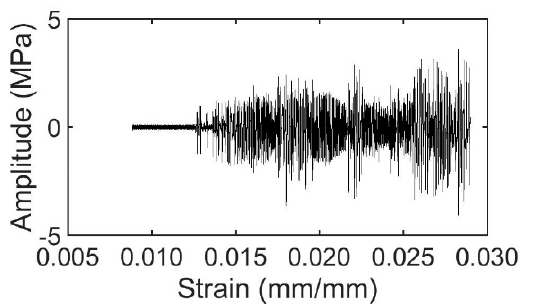
Figure 9. Resulting signal after subtracting the original and filtered curve.